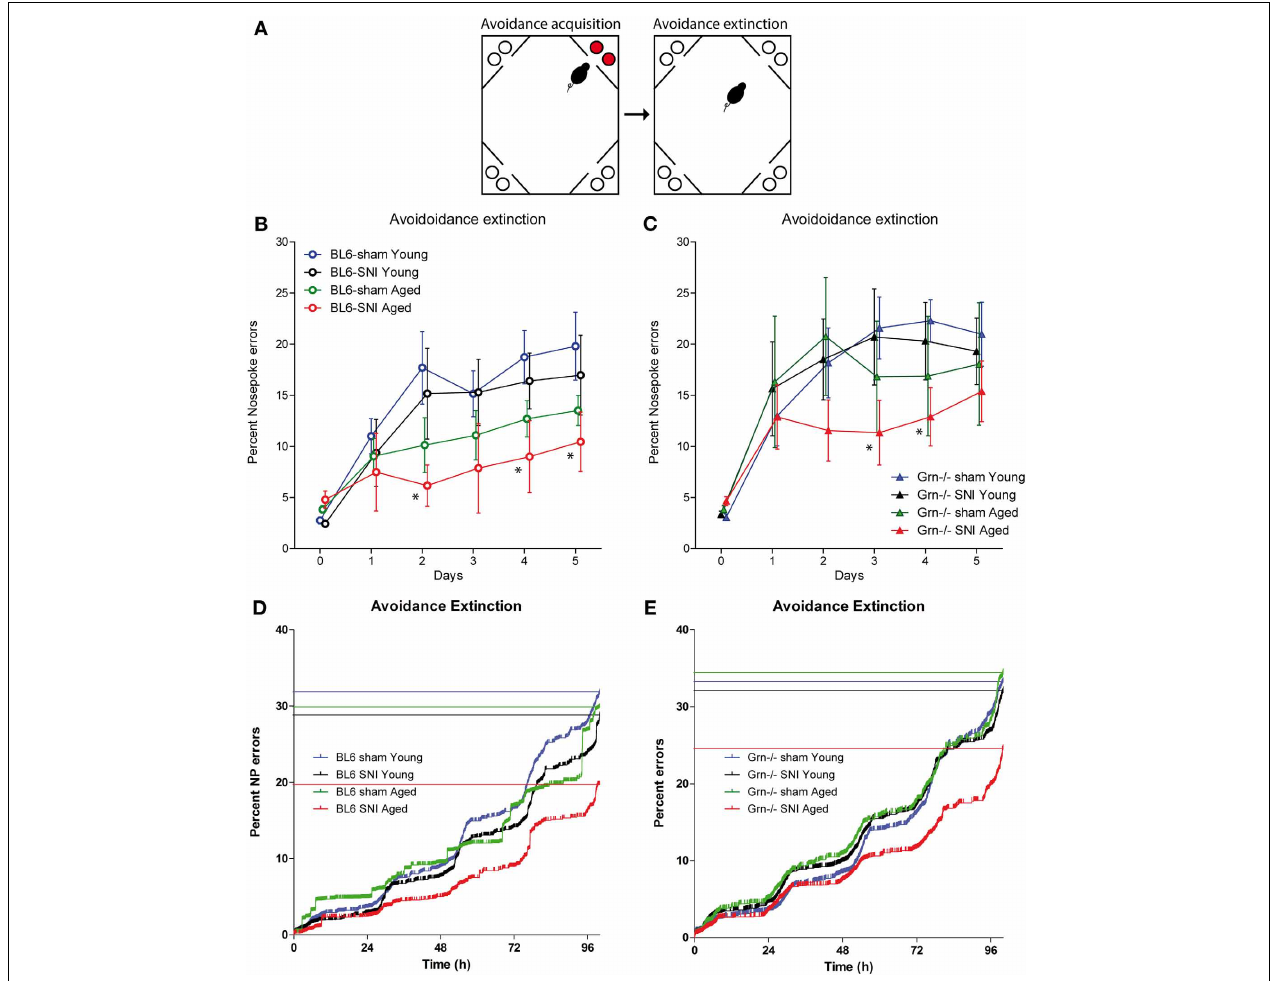
FIGURE 4 | Avoidance extinction in the IntelliCage in young and aged C57BL6/J and progranulin deficient (Grn − / − ) mice. (A) Illustration of the avoidance acquisition and extinction tasks. Red circles indicate nosepokes where air-puff punishments were applied and water access was blocked. White circles show free water access. (B,C) Time courses of nosepoke error percentages (mean ± s.e.m) per day in C57BL6/J (B) and progranulin deficient (Grn − / − ) mice (C) ; n = 8 per group. Time “0” shows the error proportion achieved during the 24h acquisition period (mean over 24h). rm-ANOVAs revealed significant differences between groups. SNI-treated aged mice of both genotypes showed the lowest